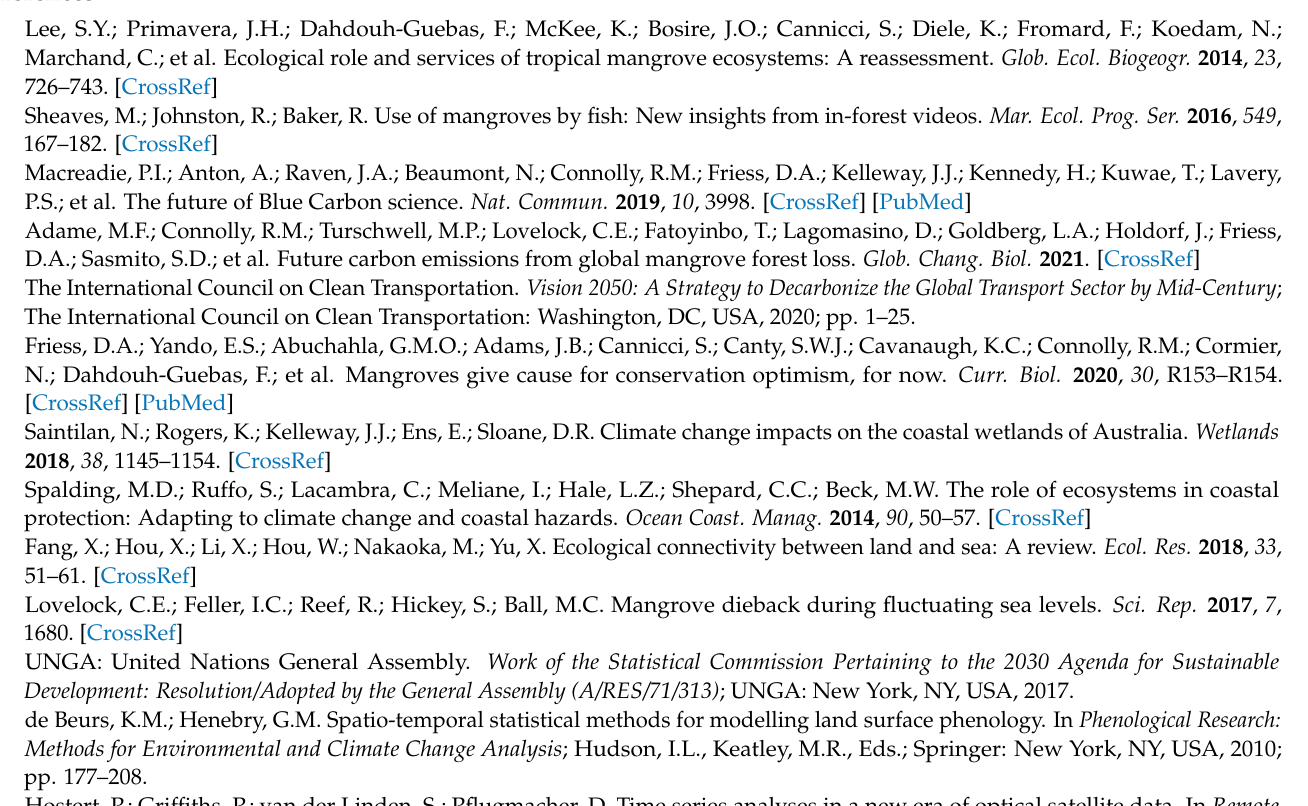
Figure S9: Mangrove forest seasonal trend decomposition in TIMESAT with Landsat NDVI data and dense time-series 1999–2020, northern section of our study region, Repulse Bay, black line indicates the seasonal trend, grey dots display the start and end of the growing season, Central Queensland, Figure S10: Mangrove forest seasonal trend decomposition in TIMESAT with Landsat NDVI data and dense time-series 1999–2020, southern section of our study region, Herbert Creek bordering Shoalwater and Corio Bays Area Ramsar Wetland, black line indicates the seasonal trend, grey dots display the start and end of the growing season, Central